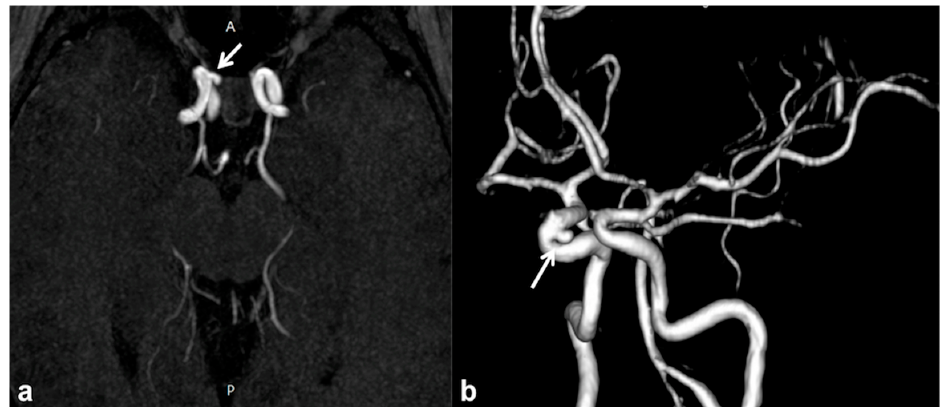
Figure 4. Non-contrast time-of-flight 3D MR angiography maximum intensity projection on the axial plane ( a ) and its volume rendering reconstruction ( b ) in a 10 year-old boy with NF1, showing the presence of a small saccular aneurysm of the right cavernous internal carotid artery (white arrows). MMS is defined as a progressive cerebrovascular angiopathy in the setting of a predis- posing condition, such as phakomatoses, caused by narrowing or stenosis in Willis’